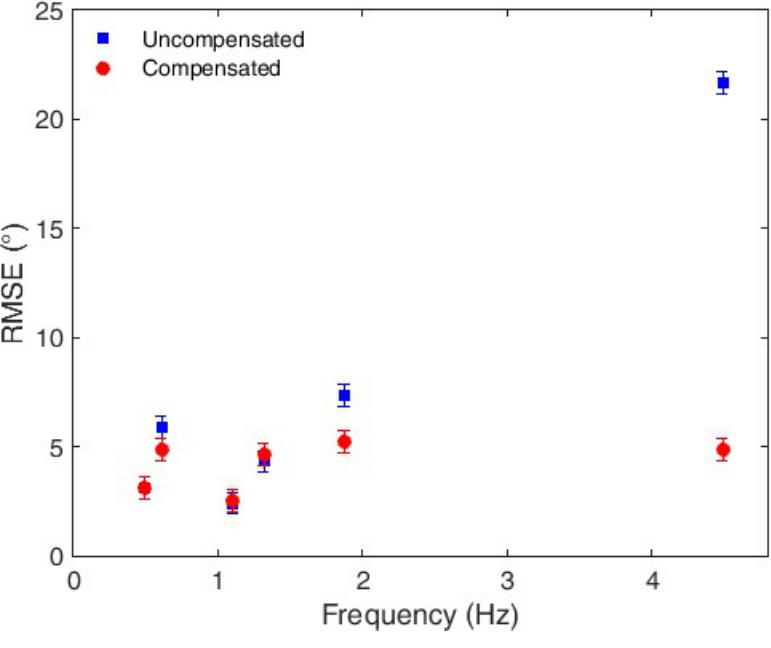
Figure 10. RMSE of the compensated and uncompensated responses at each tested frequency.